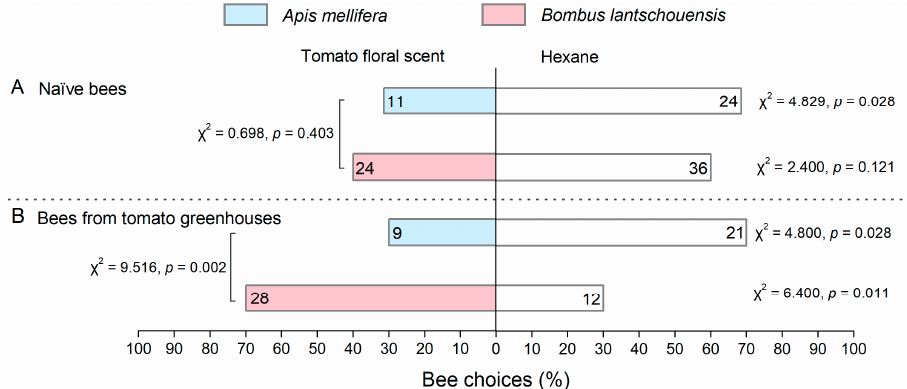
Figure 4. Behavioral responses of Apis mellifera and Bombus lantschouensis to tomato floral scent in Y-tube olfactometer. ( A ) Naïve bees from colonies that had never been used to pollinate tomato planted in a greenhouse or outside; ( B ) Bees from colonies in tomato greenhouses. The numbers in each bar represent the numbers of bees that made a choice. A one-sample chi-square test was used to analyze whether significant differences existed in bee choices between tomato floral scent and hexane. Pearson’s chi-square test was used to analyze the influence of foraging experience on the choice of the bees and to compare the differences in choice between the two bee species.